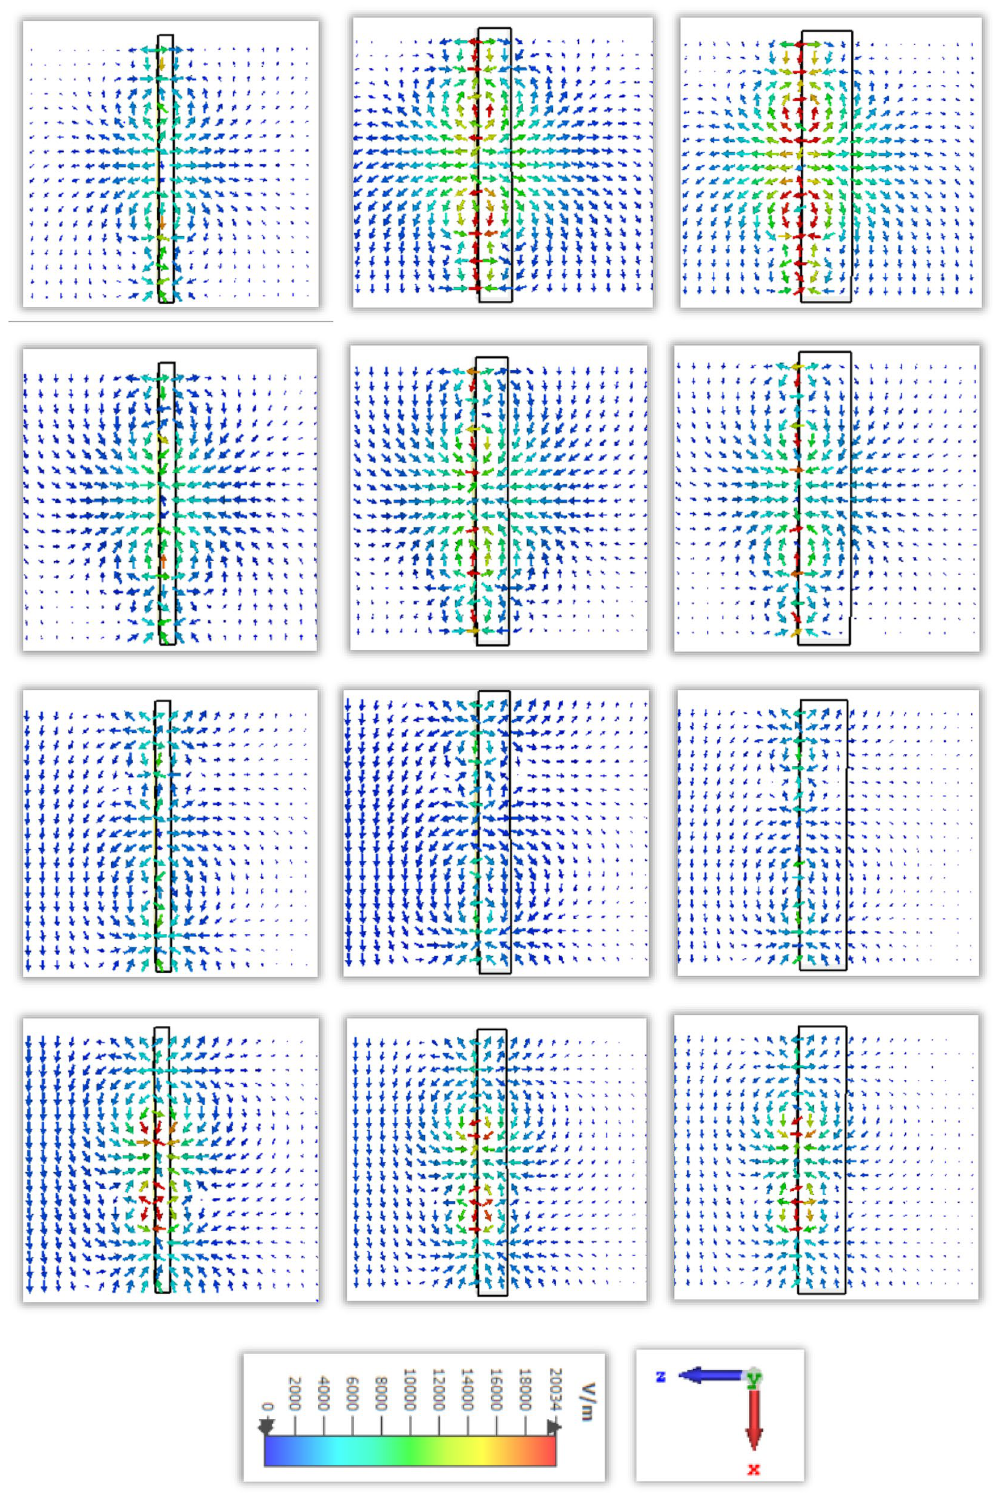
Figure 14. Electric field distribution for different thickness in row-wise ascending from the top order for 1.87, 2.55, 4.32, 5.46 GHz